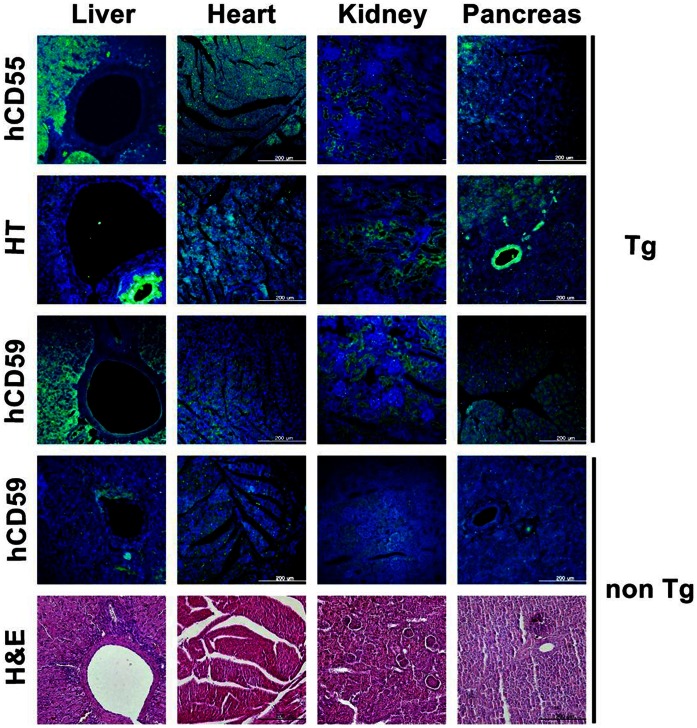
Immunohistochemical analysis in tissue sections of a transgenic piglet.Cryosections of the tissues were subjected to liver, heart, kidney and pancreas from a piglet. Frozen tissues were sectioned and immunostained with antibodies (green) as described under the Materials and Methods section. Nuclei were visualized by DAPI staining (blue). The images were taken using an inverted epifluorescence microscope. hCD55 and HT staining were barely detectable in tissue sections from non Tg, which were not included. Scale bar, 200 µm.